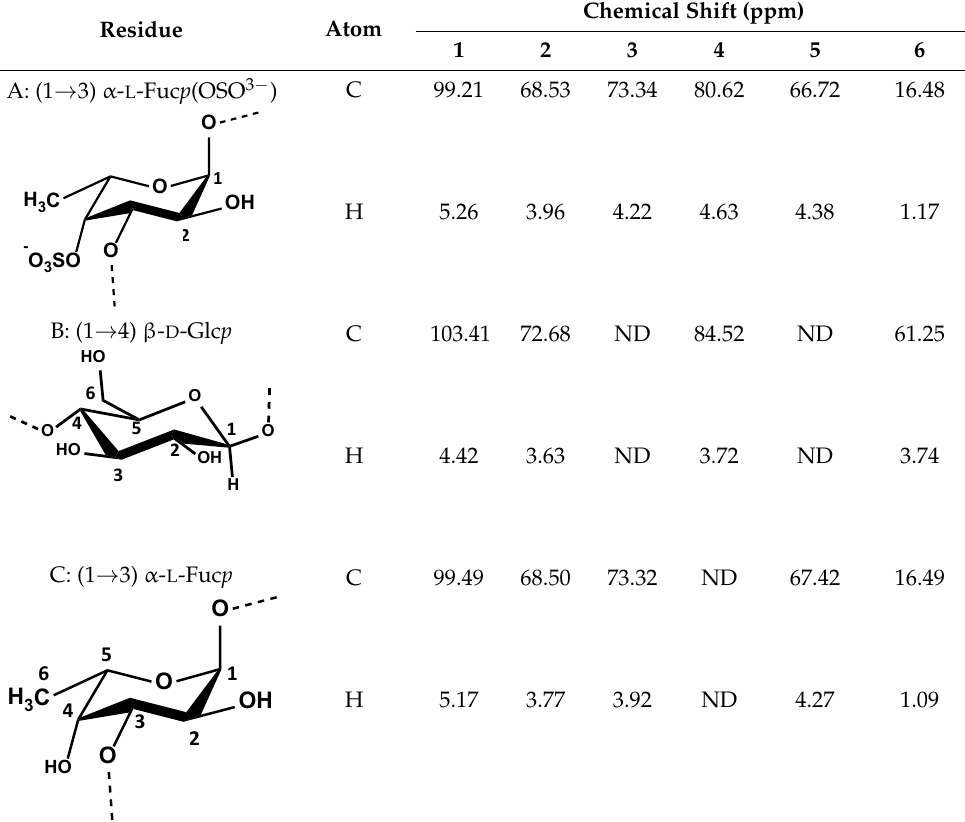
Table 2. Proposal structure of the residues for polysaccharides in S. filipendula. Chemical Shift Residue Atom